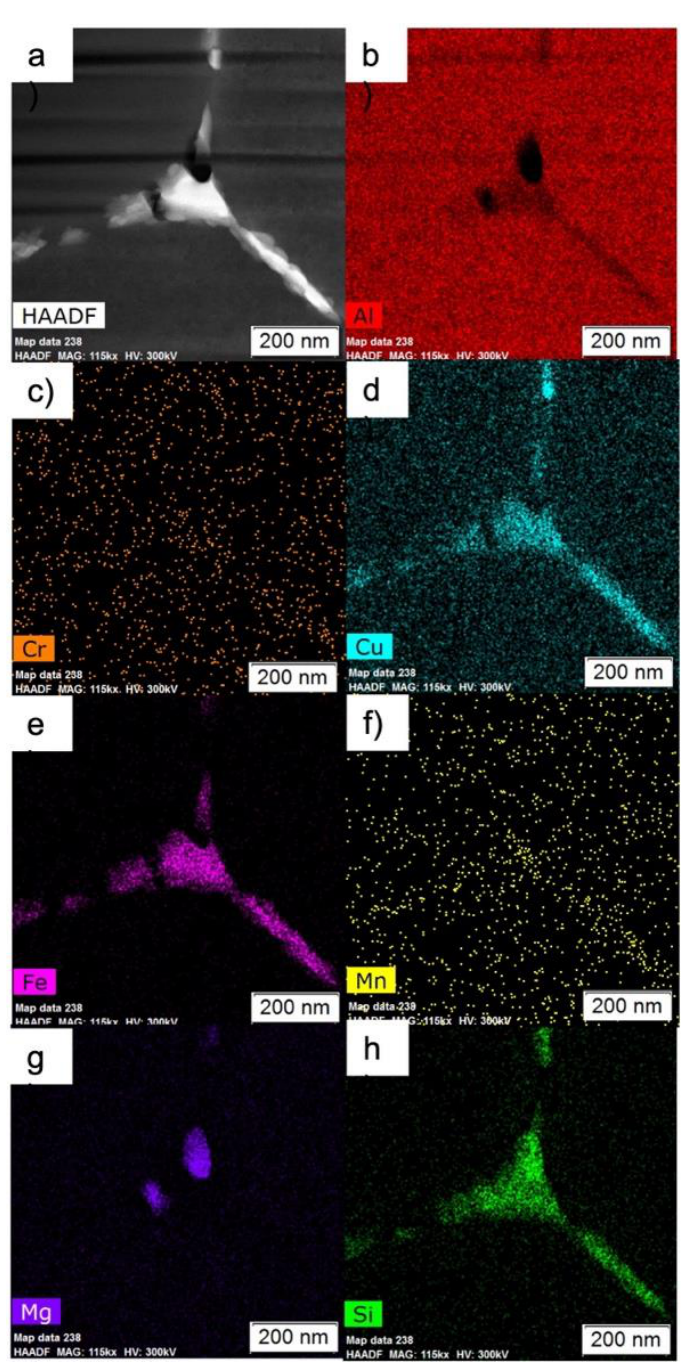
Figure 5. High magnification ( a ) HAADF, and EDS maps of ( b ) Al, ( c ) Cr, ( d ) Cu, ( e ) Fe, ( f ) Mn, ( g ) Mg, and ( h ) Si showing Mg 2 Si and Al 13 Fe 4 at a triple point in the as-atomized powder. A HAADF image and overview EDS maps of the powder microstructure in the thermally treated condition using TEM are displayed in Figure 6. Note that the Fe-rich phases and Mg 2 Si are no longer alternating and that the Mg 2 Si at the grain corners has substantially grown. Figure 7 displays high magnification HAADF and EDS maps of an Fe-rich phase, noting the incoherent boundaries, and the accumulation of Cr in the